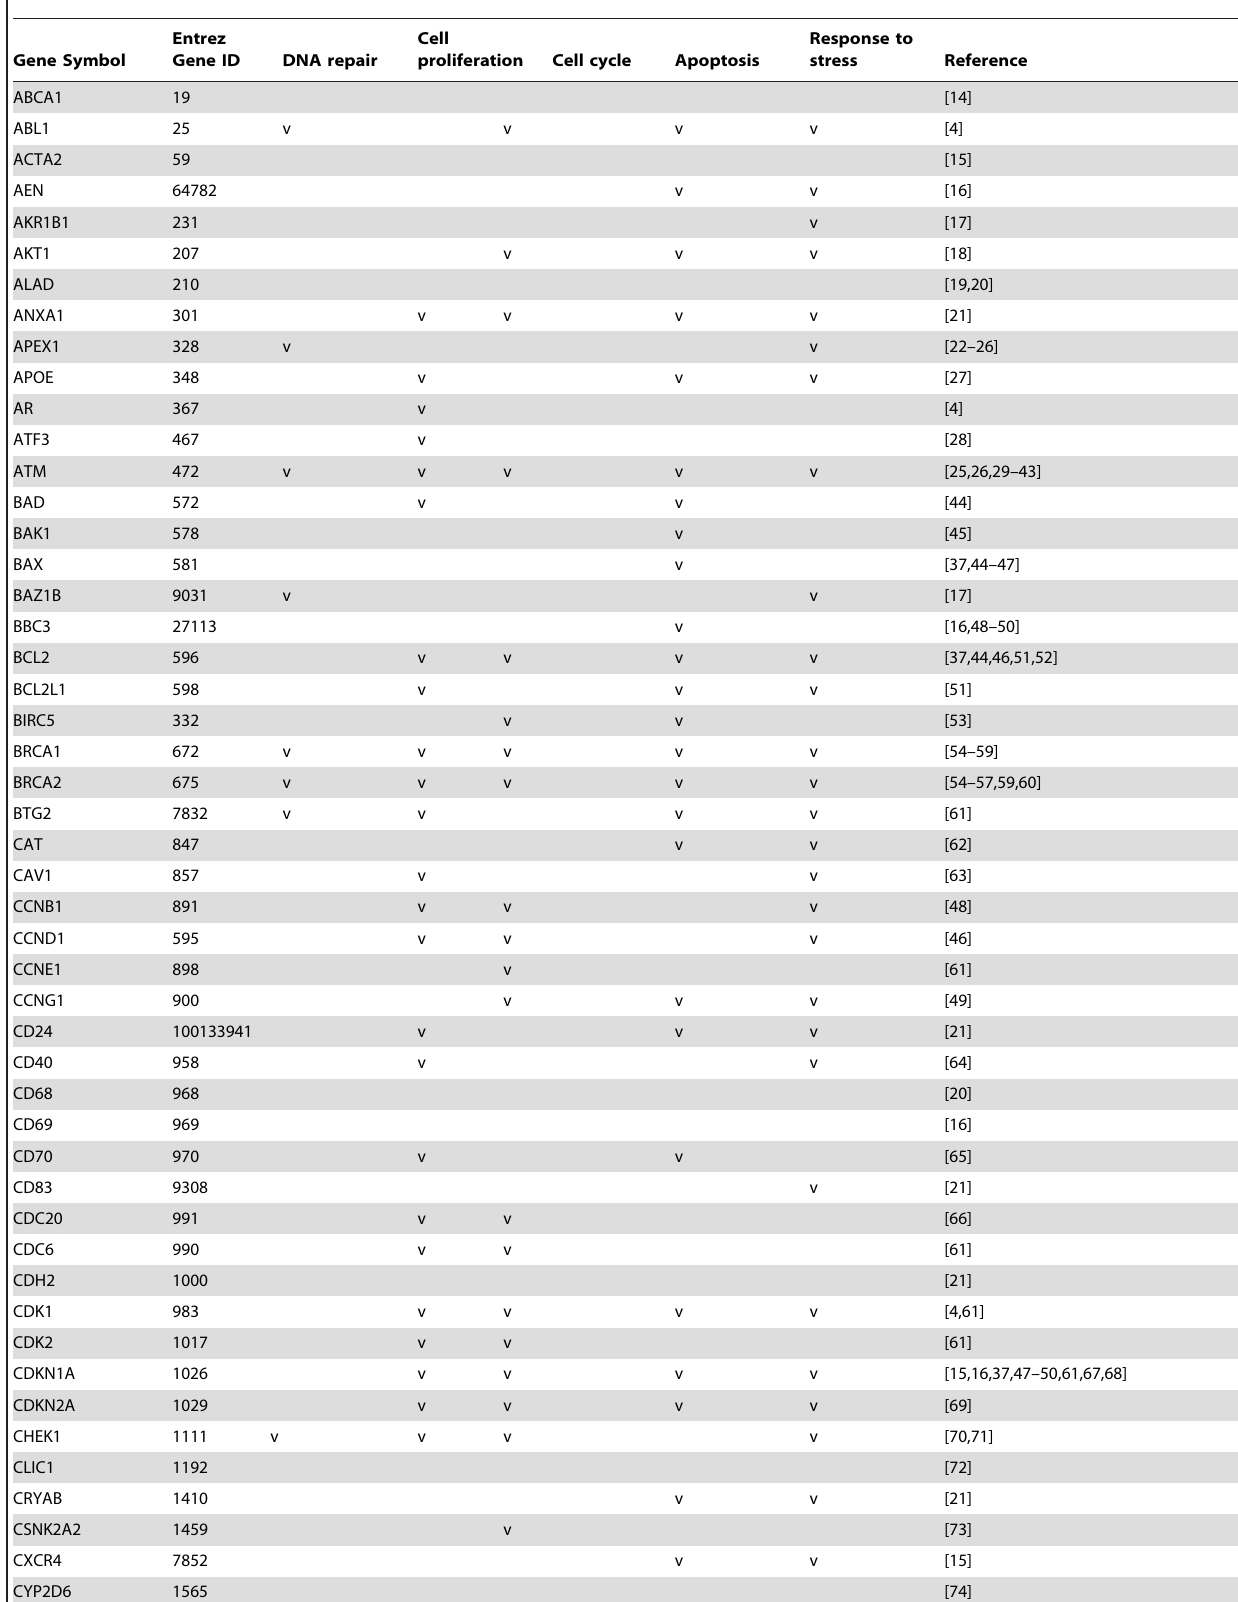
Table 1. Radio-responsive biomarkers identified by literature review and their biological